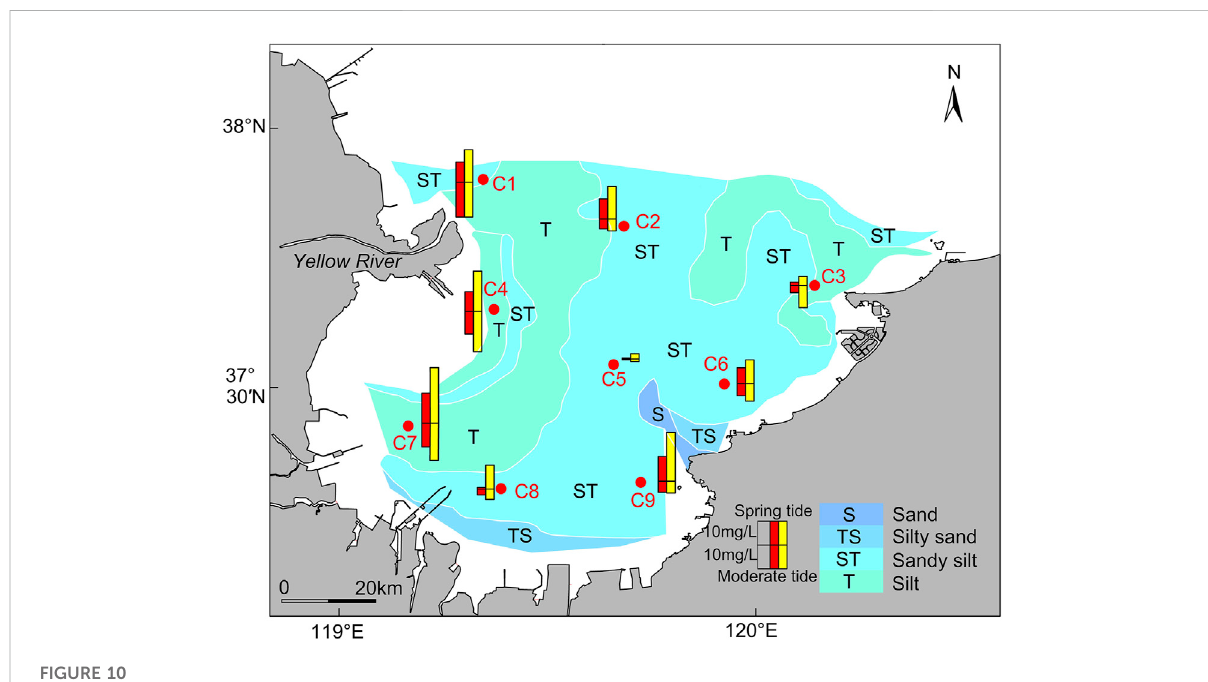
FIGURE 10 Distribution of seabed sediment types (adapted from Qiao et al. (2010)) and distribution of the surface (red rectangle) and bottom SSC (yellow